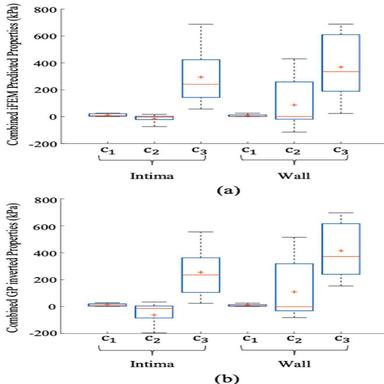
The iFEM predicted results for 13 cross sections (a) and GP inverted model predictions (b) for checking a possible non-uniqueness existing in DPTBO based iFEM solutions.